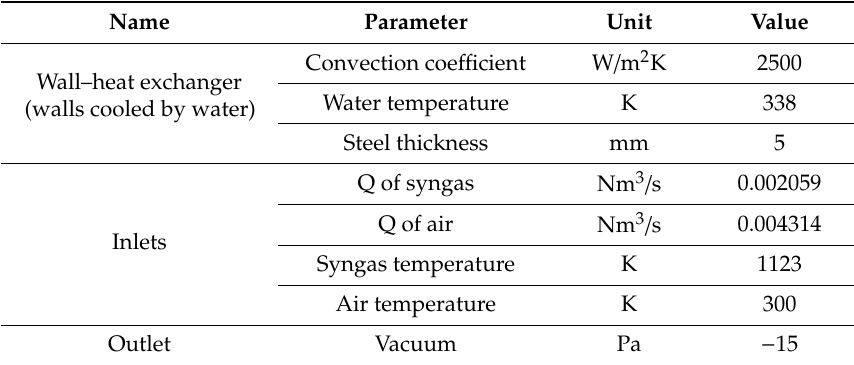
Table 3. Boiler’s full-load data (N—standard temperature and pressure: 20 ◦ C, 1013